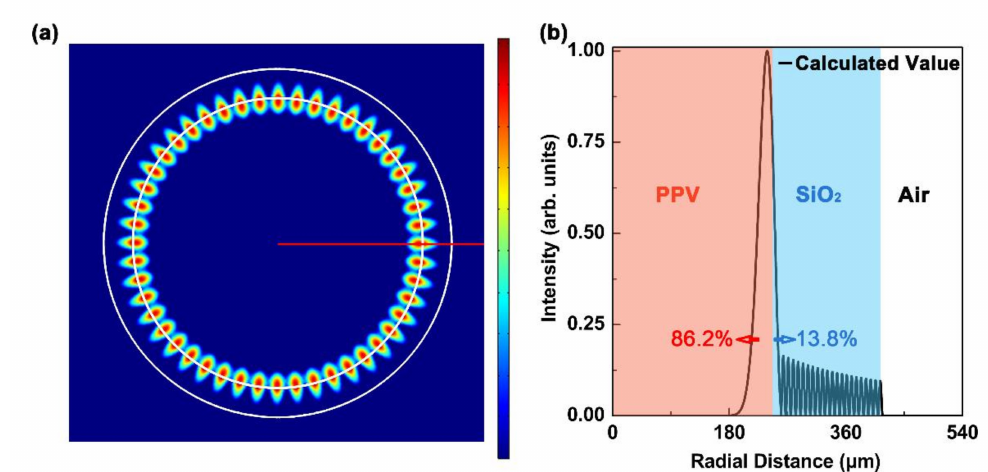
Figure 3. Simulated electric field distribution (transverse-electric mode (TE 0 )) of the capillary-tube liquid-polymer cavity. ( a ) Top view of the electric field distribution of the laser cavity. The white circles denoted the boundaries of the capillary tube. ( b ) Simulated intensity profile (TE 0 ) of the capillary tube cross section along the red line in ( a ).